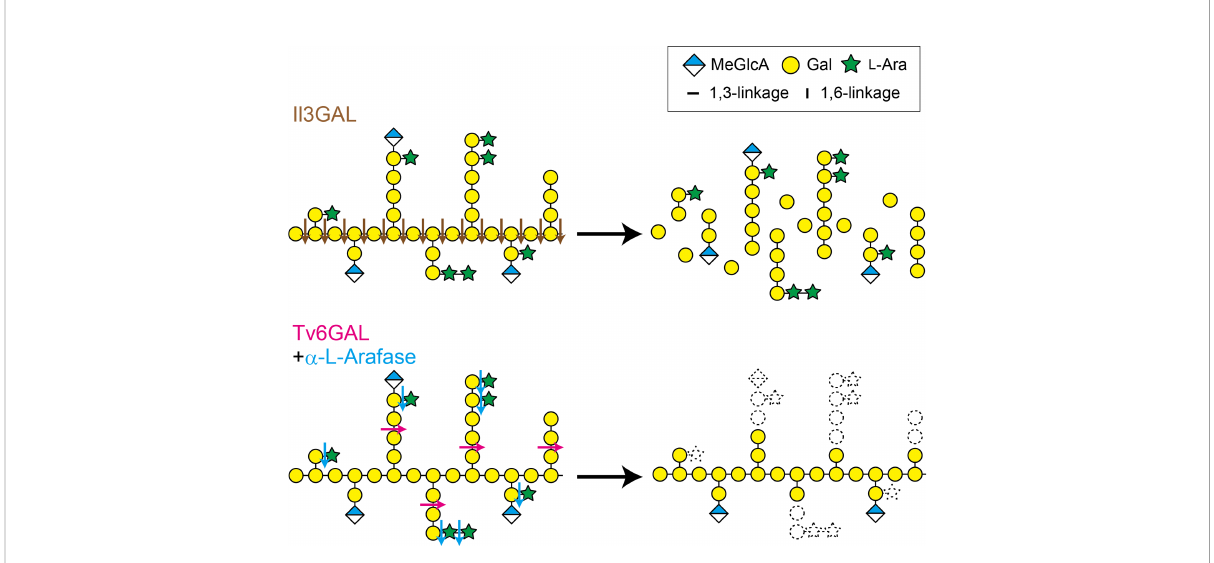
FIGURE 1 Il3GAL and Tv6GAL act differently on type II AG. Il3GAL speci fi cally hydrolyzes the b -1,3-galactan main chain irrespective of the presence of b - 1,6-galactan side chains. As a result of the action of Il3GAL, type II AG is degraded into oligosaccharides. Tv6GAL speci fi cally hydrolyzes long b - 1,6-galactan side chains of type II AG longer than b -1,6-Gal 2 , leaving only short side